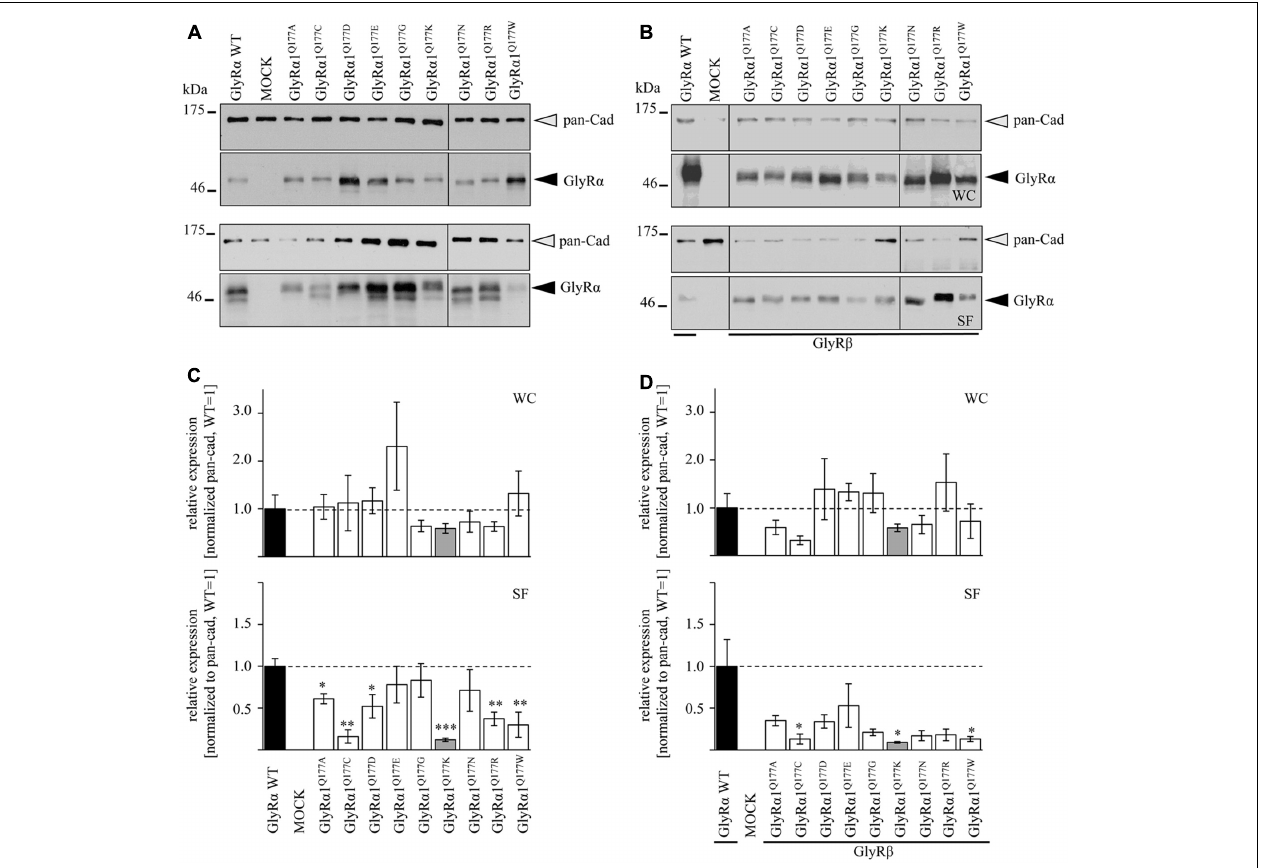
FIGURE 3 | The surface expression is influenced by mutations at position GlyR α 1 Q177 . (A,B) Biotinylation assays were performed to quantify the expression of GlyR α 1 Q177 variants and distinguish between whole cell (WC) and surface (SF) proteins level. Samples were analyzed by Western blotting using the GlyR pan- α antibody mAb4a (black arrowhead, 48 kDa). Pan-cadherin served as loading control (gray arrowhead, 135 kDa). Cells transfected with only GFP (MOCK) were used as negative control. Three to four independent experiments were performed. Note, an enhanced degradation for variants GlyR α 1 Q177D , GlyR α 1 Q177R , and GlyR α 1 Q177W . Vertical lines indicate that protein bands were taken from different gels of the same experiment. (C,D) WC and SF protein levels of independent biotinylation assays without GlyR β (C) or with GlyR β (D) co-expression were normalized to the loading control pan-cadherin of the same sample and further correlated to GlyR α 1 WT expression which was set to 1 (see dotted line in (C) and (D) ; equals 100%, Table 1 ). Error bars refer to the standard error of the mean (SEM). Level of significance refer to ∗ p < 0.05, ∗∗ p < 0.01, ∗∗∗ p <